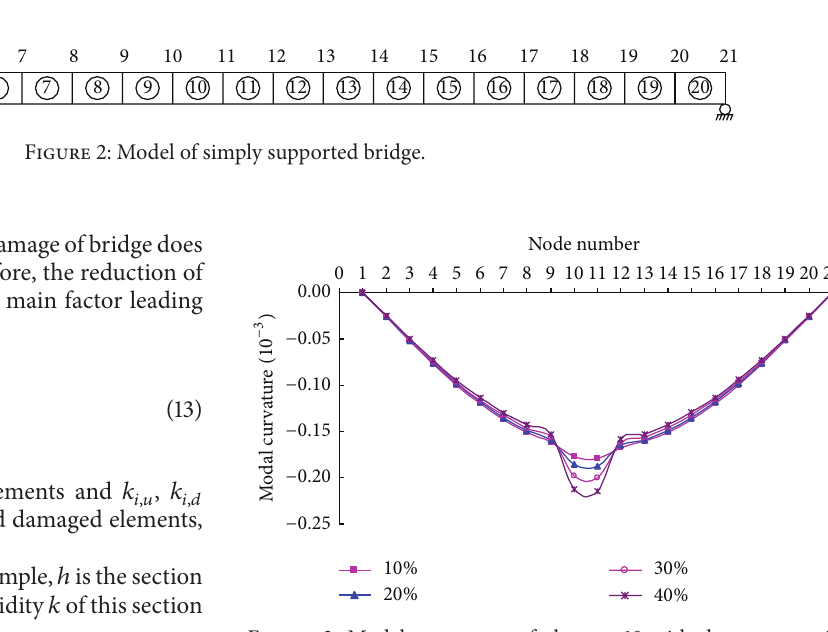
Figure 3: Modal curvatures of element 10 with damage severity (10%, 20%, 30%, and 40%).